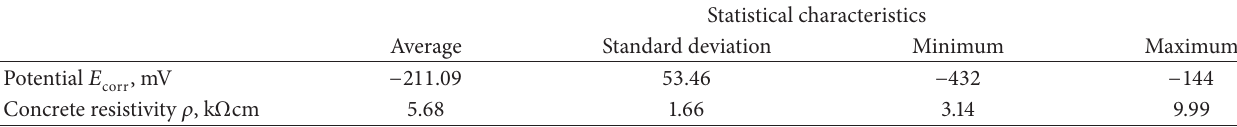
Table 5: Selected statistical characteristics of parameters determined by half-cell potential and concrete resistivity measurements.